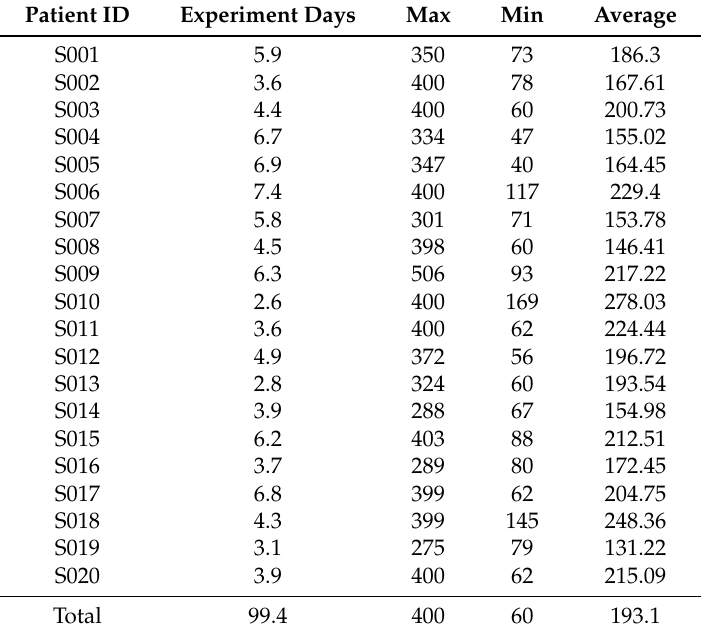
Table 2. Distribution of the glucose levels of patients.